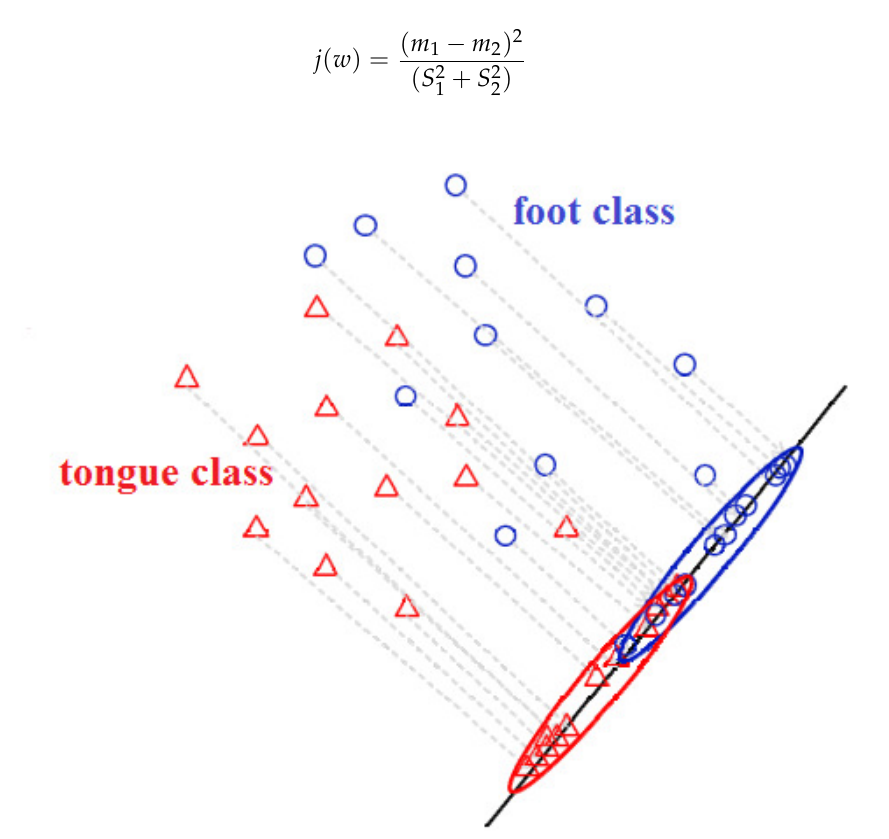
Figure 2. The example of LDA